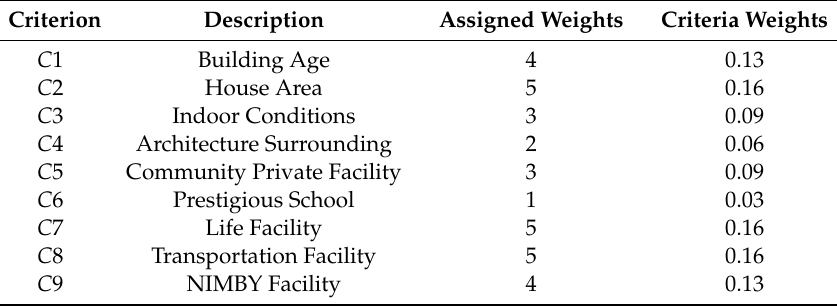
Table 7. Calculation of decision maker preference